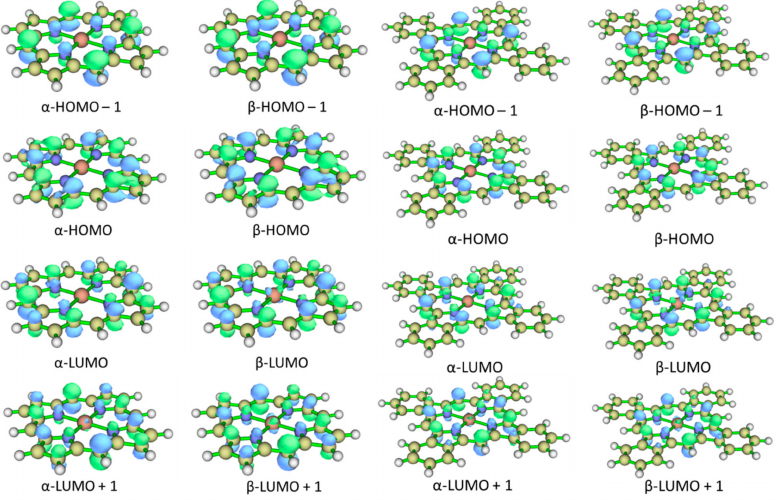
Figure 6. Shapes of the frontier molecular orbitals of FeP and FeTBP